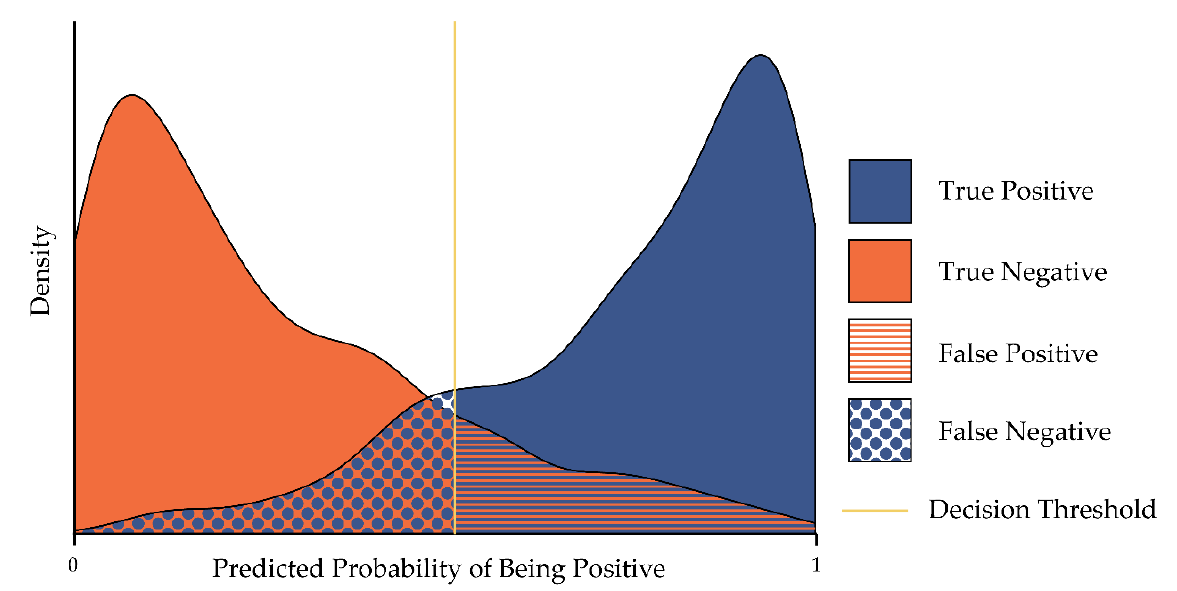
Figure 6. Conceptualization of TP, TN, FP, and FN results relative to class probabilities and a defined threshold.